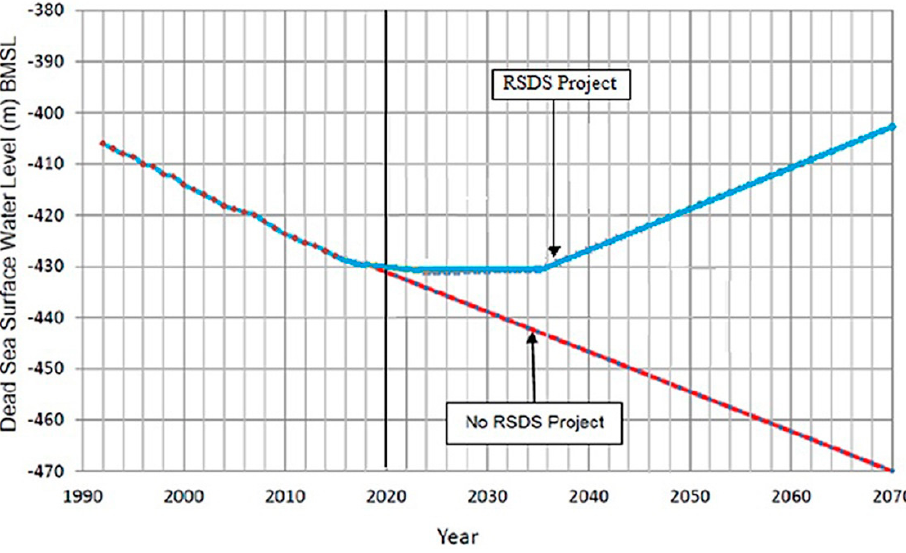
Figure 1. Predicted Dead Sea levels for different intake volumes [26].